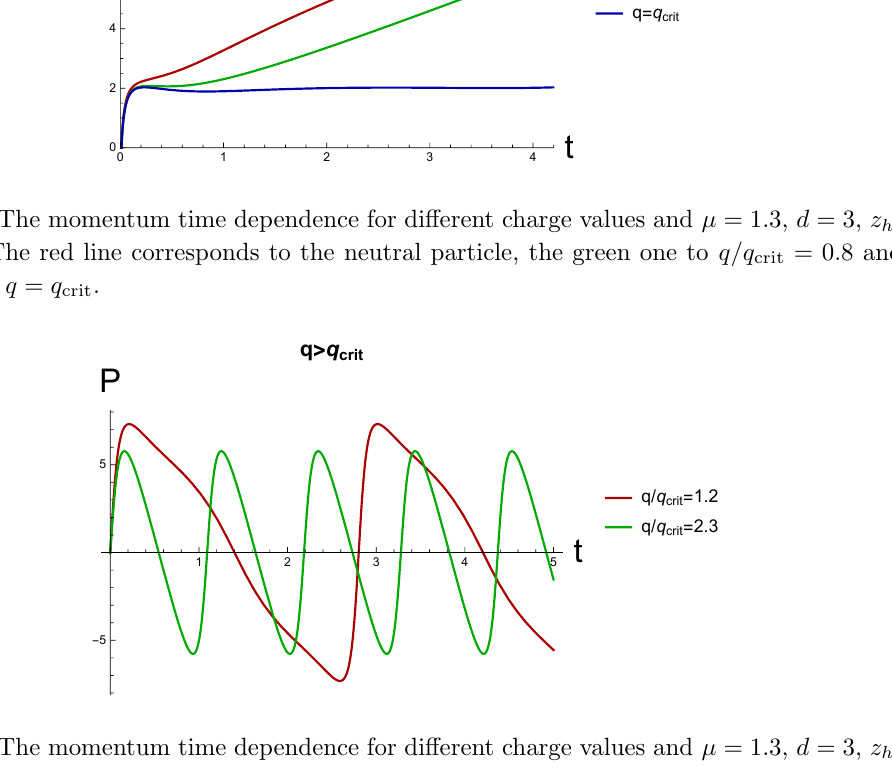
Figure 3 . The momentum time dependence for di(cid:11)erent charge values and (cid:22) = 1 : 3, d = 3, z h = 1, z (cid:3) = 0 : 1. The red curve corresponds to q=q crit = 1 : 2 and the green one to q=q crit = 2 : 3. (cid:15) Note, that for the values of charge above the critical the momentum value could